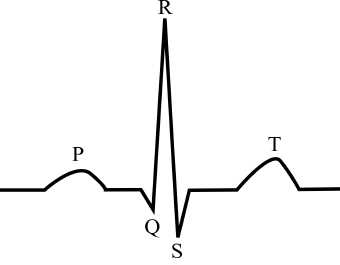
Figure 1. The main waveform in an ECG signal. P wave—Indicates atrial depolarization, or con- traction of the atrium; QRS complex—Indicates ventricular depolarization, or contraction of the ventricles; T wave—Indicates ventricular